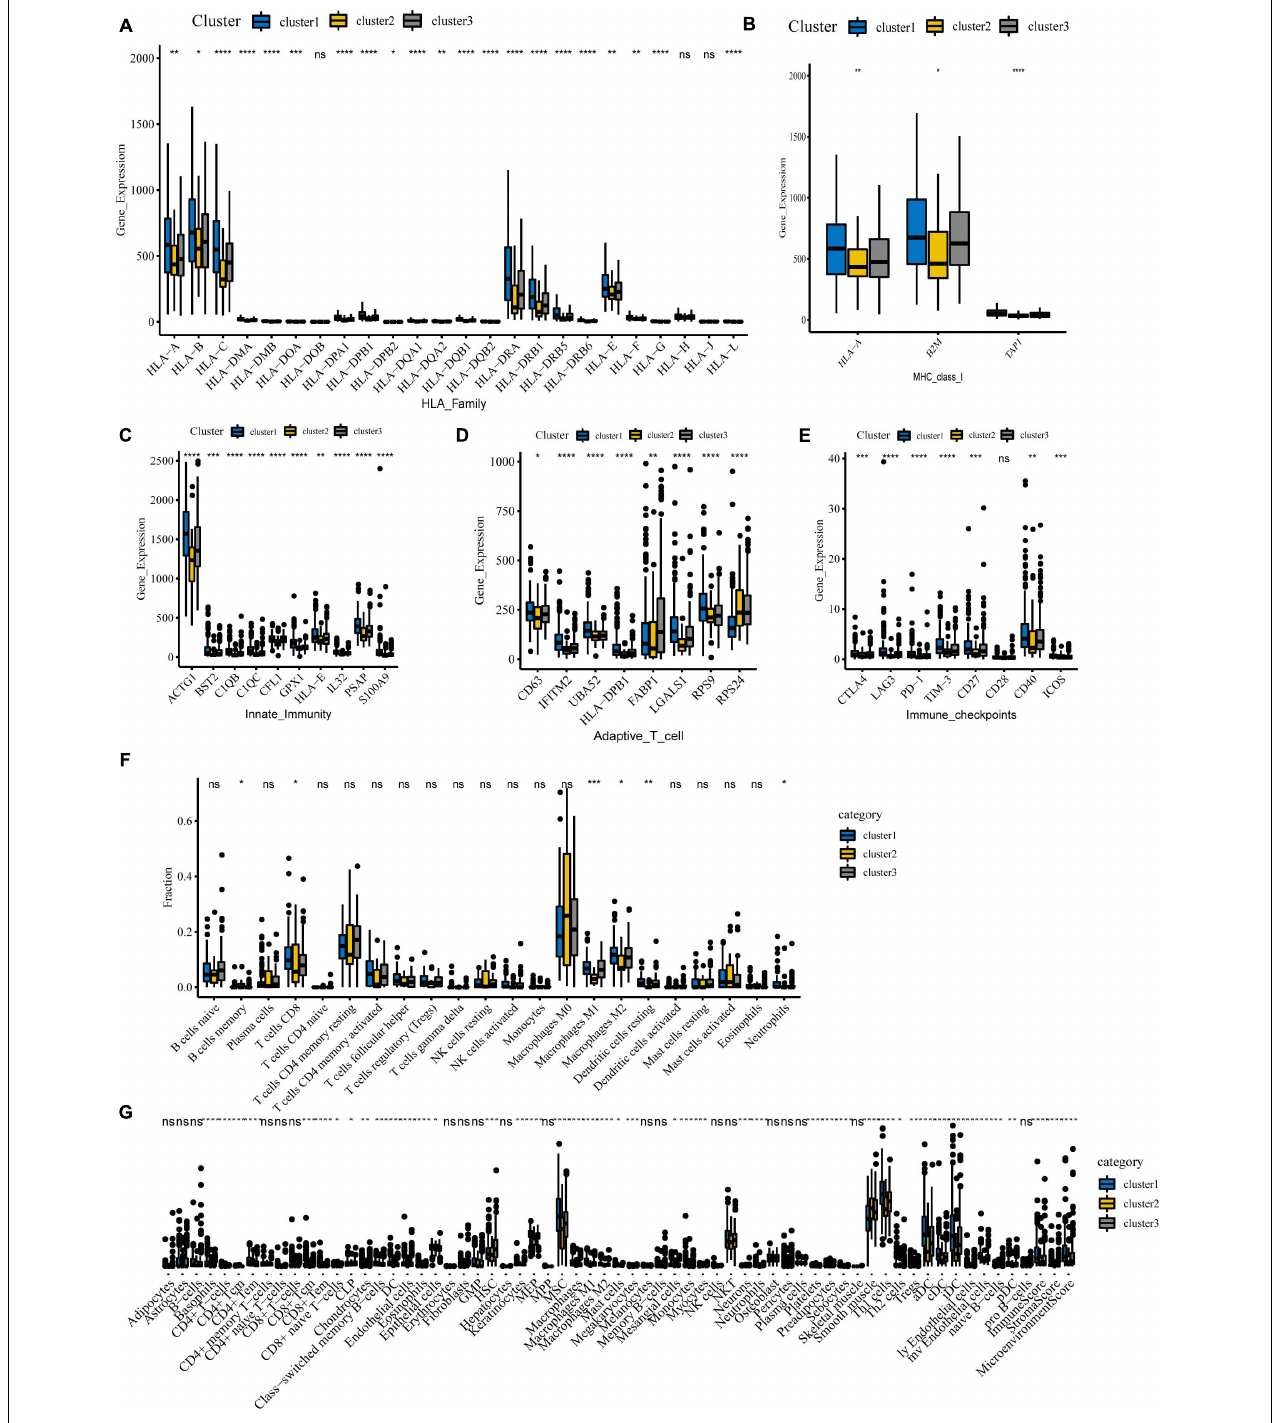
FIGURE 6 | Immune landscape among three m6A-lncRNAs patterns. (A,B) According to the TCGA-COAD tumor cohort, the total transcriptome profile of immune genes was analyzed for differences among subgroups. Differential levels of HLA family genes (A) and MHC-I molecules (B) between the clusters. (C–E) Differential expression of innate immunity associated genes (C) , activation of T cells (D) , and relevant immune checkpoints (E) . (F) Differences in the infiltration levels of 22 immune cell types in three m6A patterns using the CIBERSORT algorithm. (G) Differences in the levels of infiltration of the 64 immune cells in three clusters using the Xcell website (**** P < 0.0001; *** P < 0.001; ** P < 0.01; * P < 0.05).